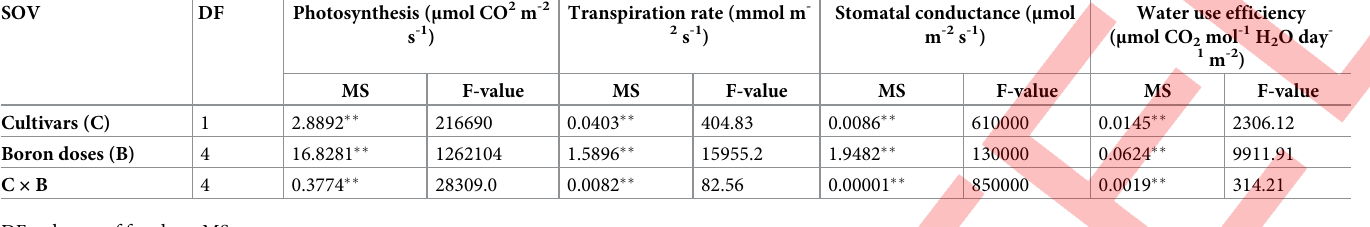
Table 3. Analysis of variance of soil applied boron doses on photosynthesis, transpiration rate, stomatal conductance and water use efficiency of cotton cultivars. SOV DF